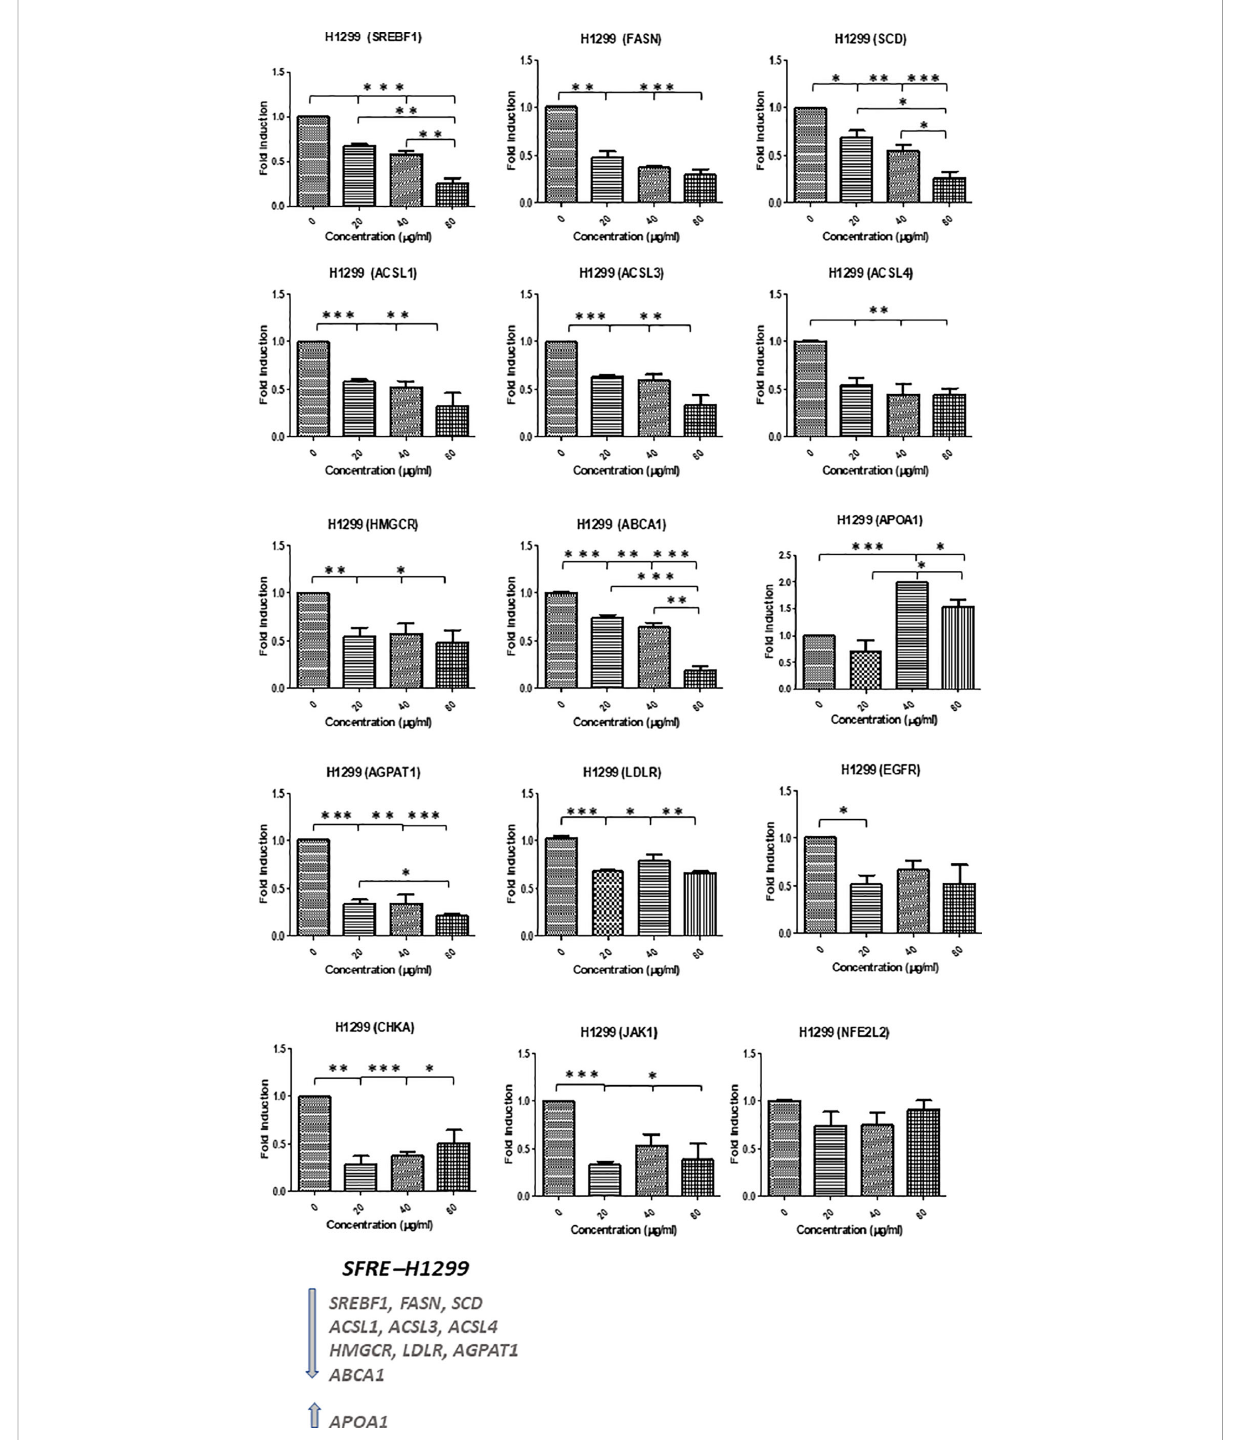
FIGURE 4 Effects of SFRE on lipid metabolism related genes after 48 h of treatment H1299 NSCLC cells. SFRE diminishes the expression of SREBF1, FASN, SCD1, HMGCR ( de novo lipogenesis and cholesterogenesis); ACSL1, ACSL3 and ACSL4 (fatty acid activation); ABCA1 (ef fl ux of cholesterol and tumour microenvironment remodelling); CHKA and AGPAT1 (biosynthesis of phospholipids and plasmatic membrane phospholipid remodelling) and oncogenic EGFR . On the contrary, SFRE upregulated the expression of APOA1 . Results are shown in relation to non-treated cells and normalized to the endogenous control B2M . Results are expressed as the mean ± SEM of three independent experiments, each performed in triplicates. Asterisks *, **, *** indicate p values < 0.05, 0.01 and 0.005,